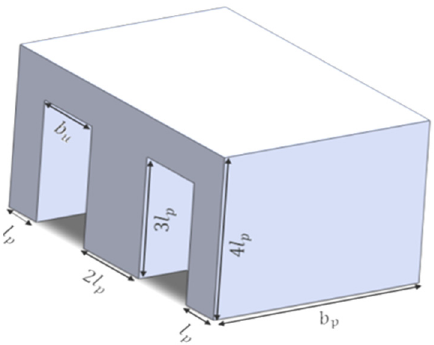
Figure 3. The cross-sectional view of the E-shaped core along with its dimensional parameters.